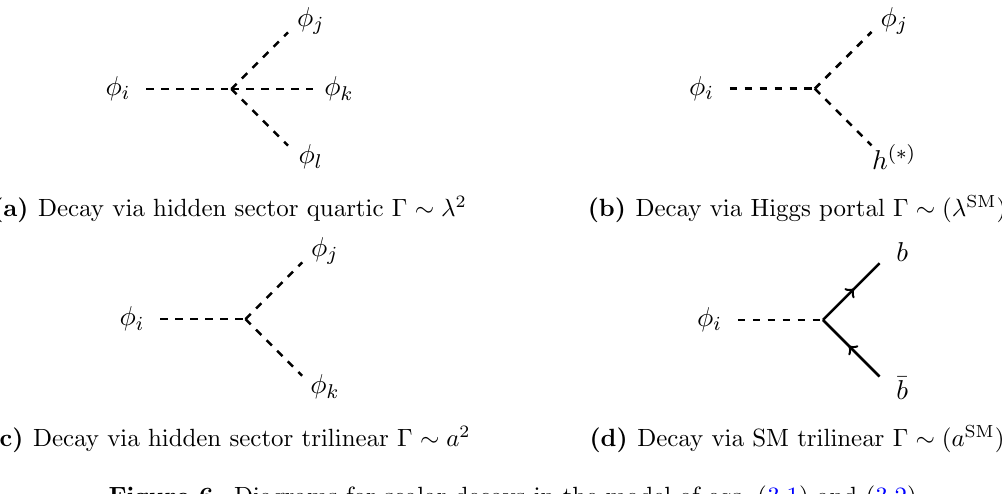
Figure 6. Diagrams for scalar decays in the model of eqs. (3.1) and